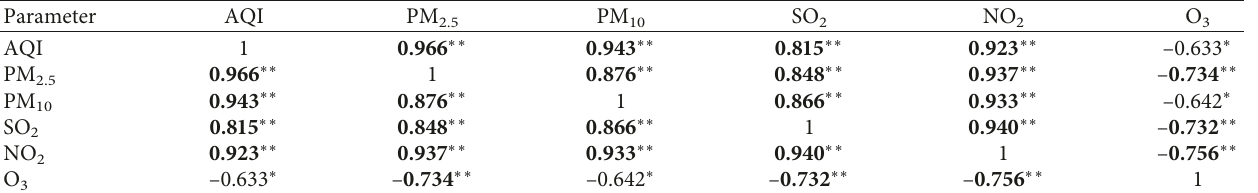
Table 5: Correlation between primary pollutants and AQI in Jiangsu between September 2017 and August 2018.